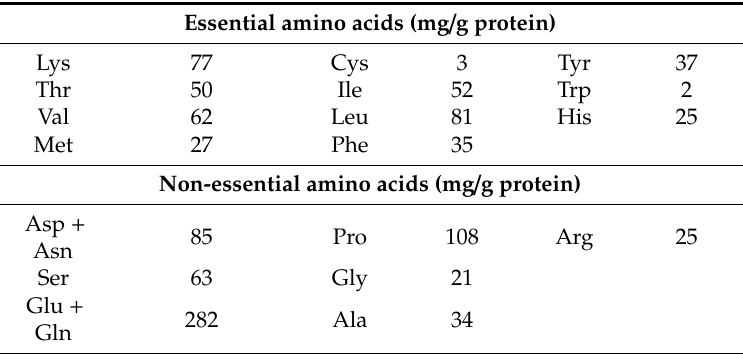
Table 1. Amino acid composition of casein